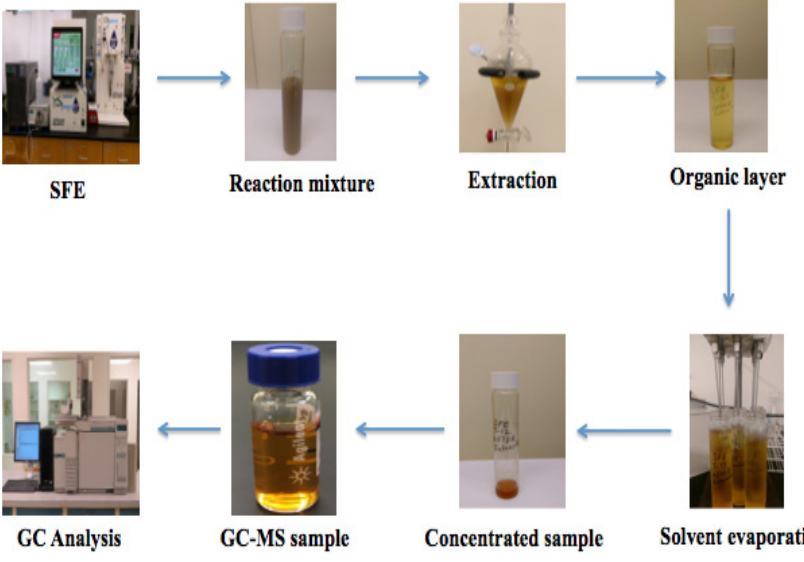
Figure 2. Stepwise process for the depolymerization of alkali lignin.